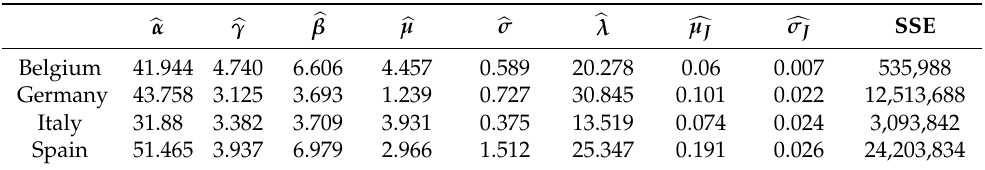
Table 9. Parameter estimates for the model ruled by Equation (33) (unit of time t : year). The SSE is the value of the optimization criterion in Equation